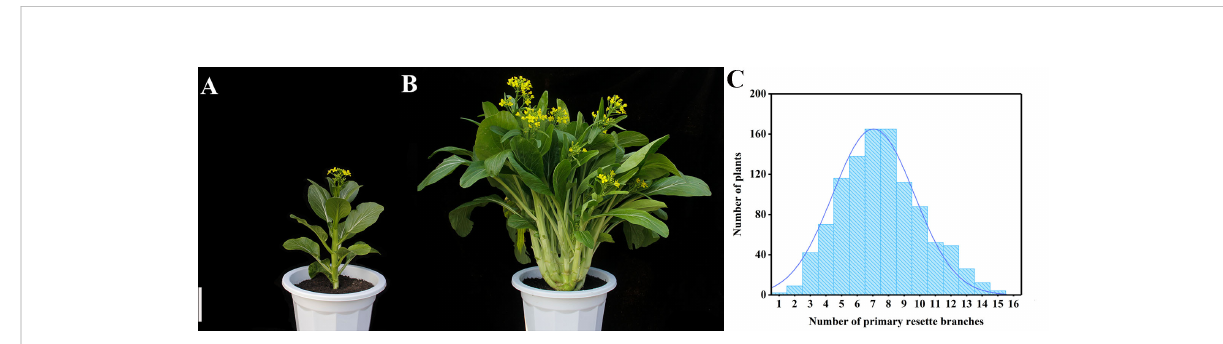
FIGURE 1 Phenotype of parent lines CX010, CX020 and distribution of the number of primary rosette branches in fl owering Chinese cabbage. (A) Non- primary rosette branching line ( ‘ CX010 ’ ). (B) Multiple primary rosette branching line ( ‘ CX020 ’ ) Bar = 10 cm. (C) Distribution of the number of primary rosette branches in 1050 individuals of F 2